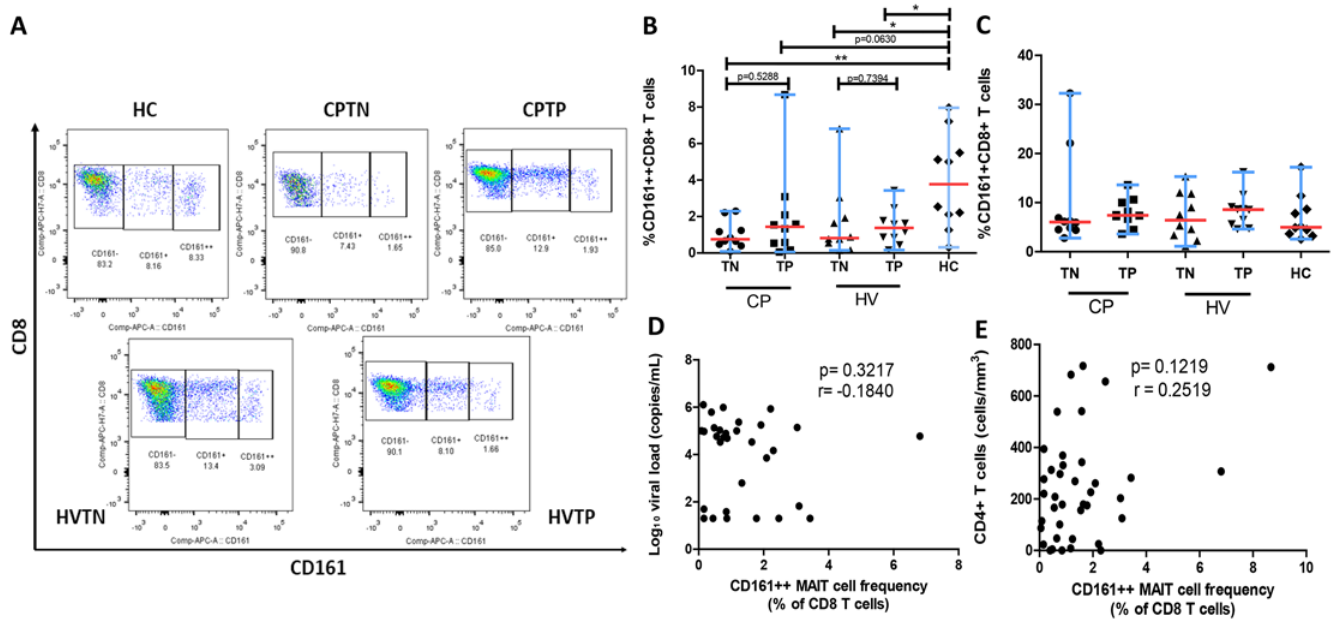
Fig 2. Percentage of CD8 + T cells expressing CD161 ++ across different study groups. (A) Scatter plots (gated on the CD3 + T-cell population) show co- staining with CD8 and CD161 on representative samples from 5 different clinical groups: CPTNs, CPTPs, HVTNs, HVTPs, and HCs. (B) CD161 ++ CD8 + T (MAIT cell) frequency in HCs showed significantly increased MAIT cell levels compared to other study groups. (C) CD161 + CD8 + T cell frequency showed no difference across the different study groups. (D-E) CD161 ++ CD8 + MAIT cell frequency in subjects with HIV mono-infection and HIV/TB co-infection shows no significant correlation with either HIV plasma viral load (copies/mL) or CD4 + T-cell counts (cells/mm 3 ). All graphs show median (red bars) and range (blue whiskers); P values are reported for two-sided Mann-Whitney tests with threshold for significance P = 0.025 after Bonferroni correction for 2 comparisons. Correlations between MAIT cell frequency and markers of HIV disease progression were assessed using two-tailed non-parametric Spearman ’ s rank. (Note: TN, treatment na ï ve; TP, treatment positive; HC, healthy control; CP, HIV/TB co-infection; HV, HIV mono-infection).